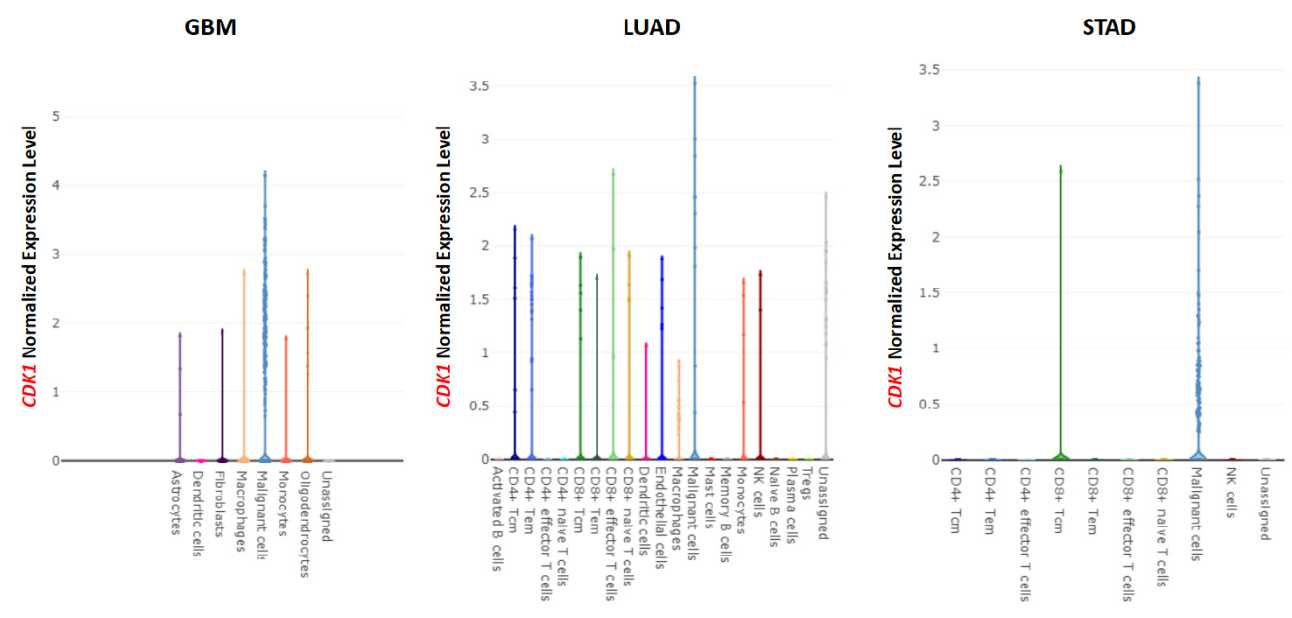
Figure 10. Single-cell data analysis of CDK1 expression in tumors. CDK1 was mainly expressed in malignant cells and also abundantly expressed in some immune cells in GBM, LUAD, and STAD. Immune checkpoint genes (ICGs) are among the critical immunotherapy targets for cancer treatment. CDK1 expression was positively related to many inhibitory ICGs, such as cluster of differentiation 276 ( CD276 ), vascular endothelial growth factor A ( VEGFA ), cytotoxic T-lymphocyte-associated protein 4 ( CTLA4 ), and programmed cell death protein 1 ( PDCD1 ) in various tumors (Figure 11A). Notably, high mobility group box 1 ( HMGB1 ) was significantly and positively related to CDK1 in 31 different types of tumors. A series of stimulatory ICGs, such as CD40 , TNF receptor superfamily member 14 ( TNFRSF14 ), and selectin P ( SELP ), were negatively linked with CDK1 in some tumors (OV, KICH, and CESC) (Figure 11A). Analysis of the correlations between the expression of CDK1 and MSI/TMB in tumors in the TCGA database showed that CDK1 expression was positively related to MSI in GBM, UCEC, TGCT, SARC, COAD, STAD, and KIRC, whereas CDK1 expression was negatively linked with MSI in DLBC (Figure 11B). In addition, high expression of CDK1 was associated with high TMB in GBM, LUAD, PRAD, UCEC, TGCT, COAD, STAD, SKCM, KIRC, KICH, ACC, and PCPG (Figure